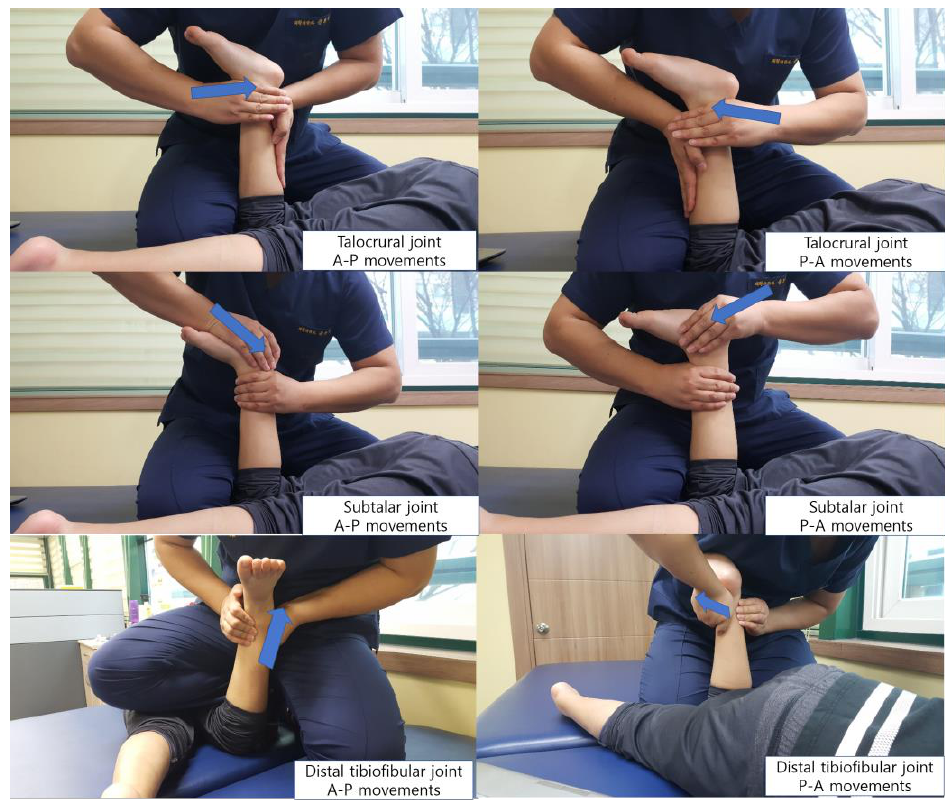
Figure 2. The ankle joint mobilization.